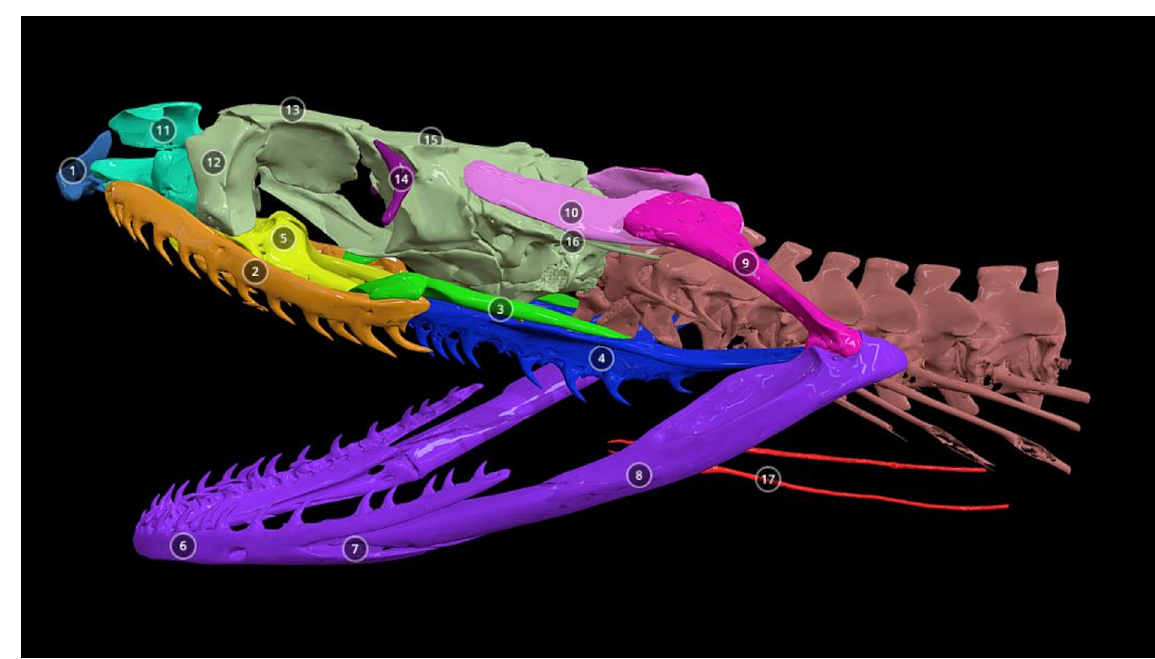
Fig. 8.2. Annotated model of a grass snake skull on Sketchfab.